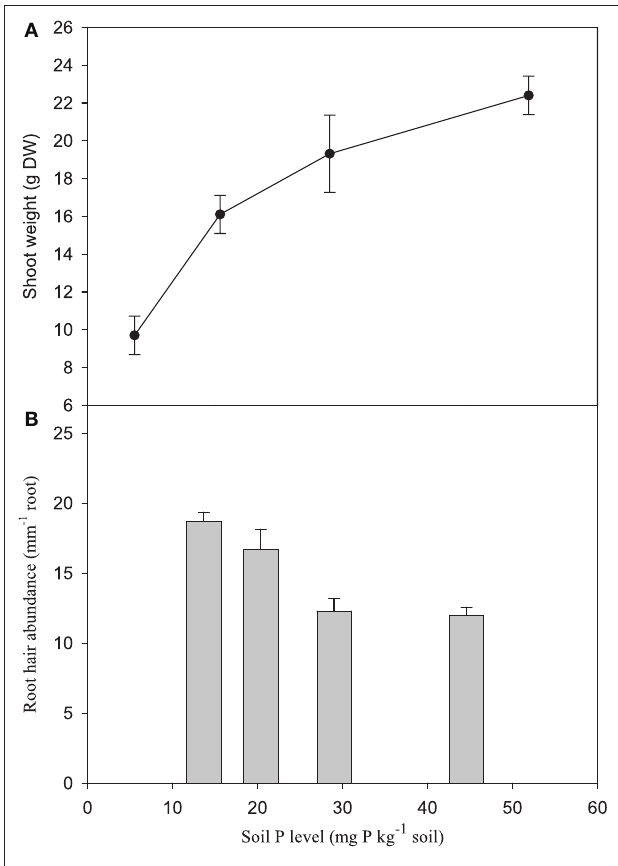
FIgure 7 | Shoot dry matter yield (A) and root hair abundance (B) for the Mn-inefficient genotype Antonia in response to increasing soil-P levels. Values are means ± SE ( n = 3).